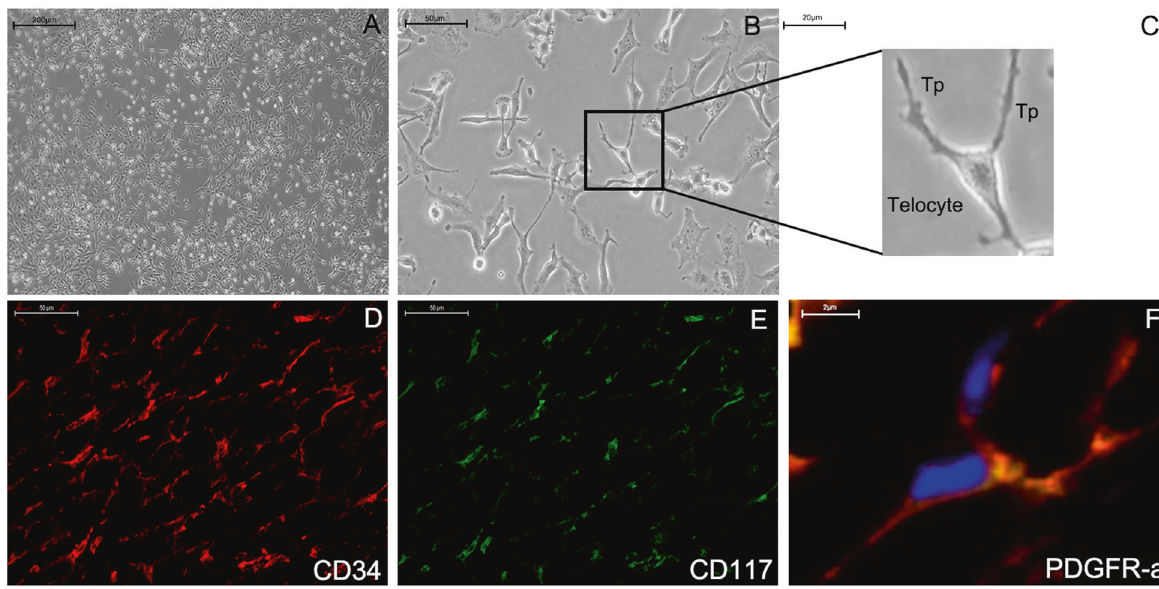
Fig. 1 Morphology and immuno fl uorescent staining of TCs. The unique morphology of TCs was observed by light microscopy (×40 in ( A ); ×200 in ( B )). The long and thin extending feature is a telopode (Tp, ×400). Three Tps emanating from the body of a TC ( C ). TCs were positive for CD34 (red, D ), CD117 (green, E ), and PDGF- α (yellow, F